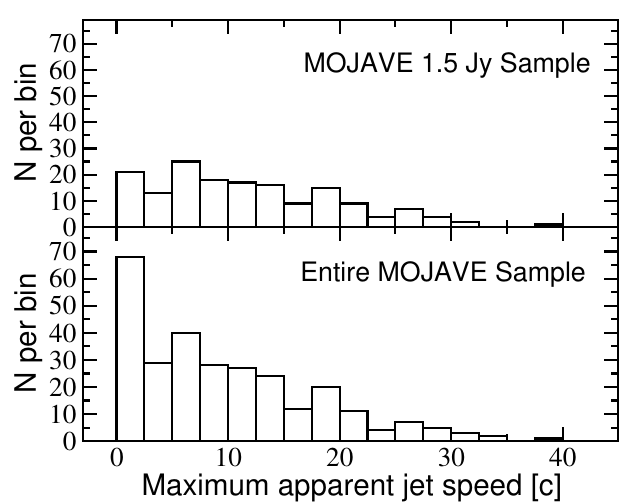
Figure 2. Top panel: distribution of maximum observed jet speed for AGN in the flux-density limited MOJAVE 1.5 Jy sample. Lower panel: maximum speed distribution for all jets measured to date by the MOJAVE program.